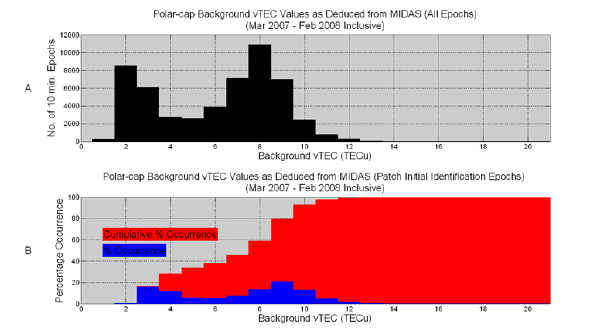
Fig. 5. (a) Background vTEC values for every time step of the MIDAS run. The highest value is 21TECu. (b) Percentage occur- rence of background vTEC values and cumulative percentage oc- currence of background vTEC values. 0.01% have a value greater than 12TECu.